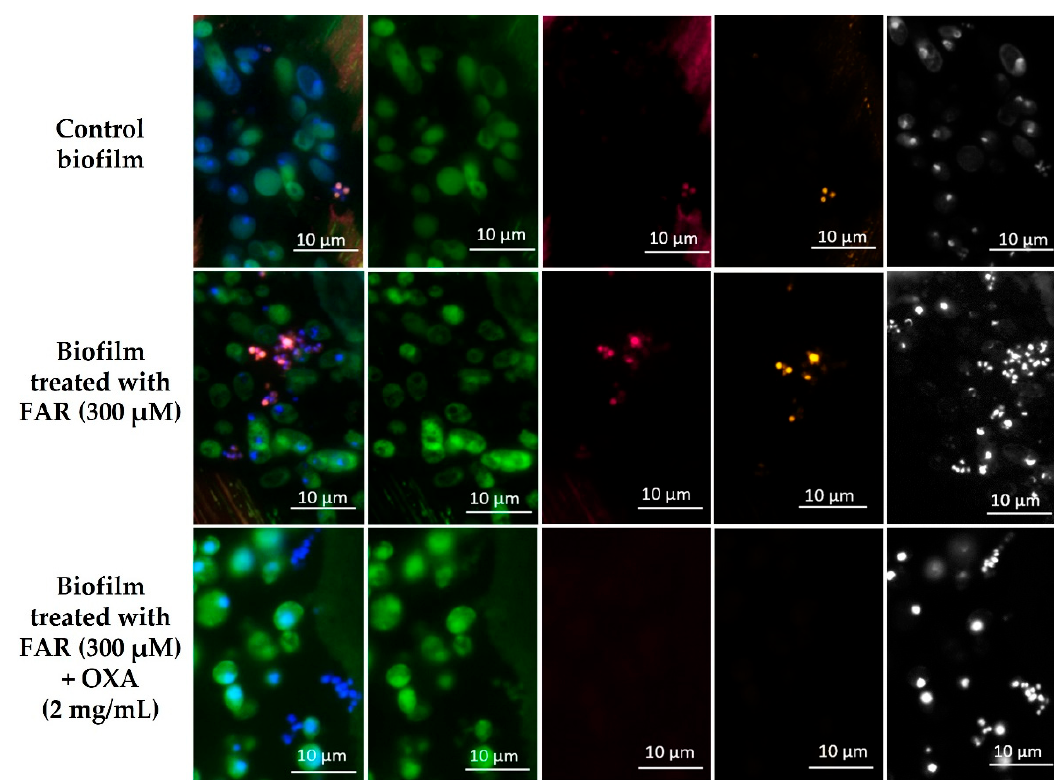
Figure 5. FISH images of mixed biofilms of C. albicans -MRSA2 after 12 h of incubation; the upper row represents control biofilm, the middle row represents the biofilm treated with FAR (300 μ M) and the lower row represents the biofilm treated with FAR (300 μ M)/OXA (2 mg/mL). Candida was hybridized with the Candida -specific FISH probe CAND10, labeled with FITC (green), almost all bacteria were hybridized with the panbacterial probe EUB338, labeled with Cy5 (magenta), Staphylococcus sp. were hybridized with Staphylococcus sp.-specific probe (STAPHY), labeled with Cy3 (yellow). Nucleic acids of all cells were stained with DAPI (shown in black-and-white). The first image in each row shows an overlay of all fluorescence channels, followed by CAND10, EUB338, STAPHY and DAPI.